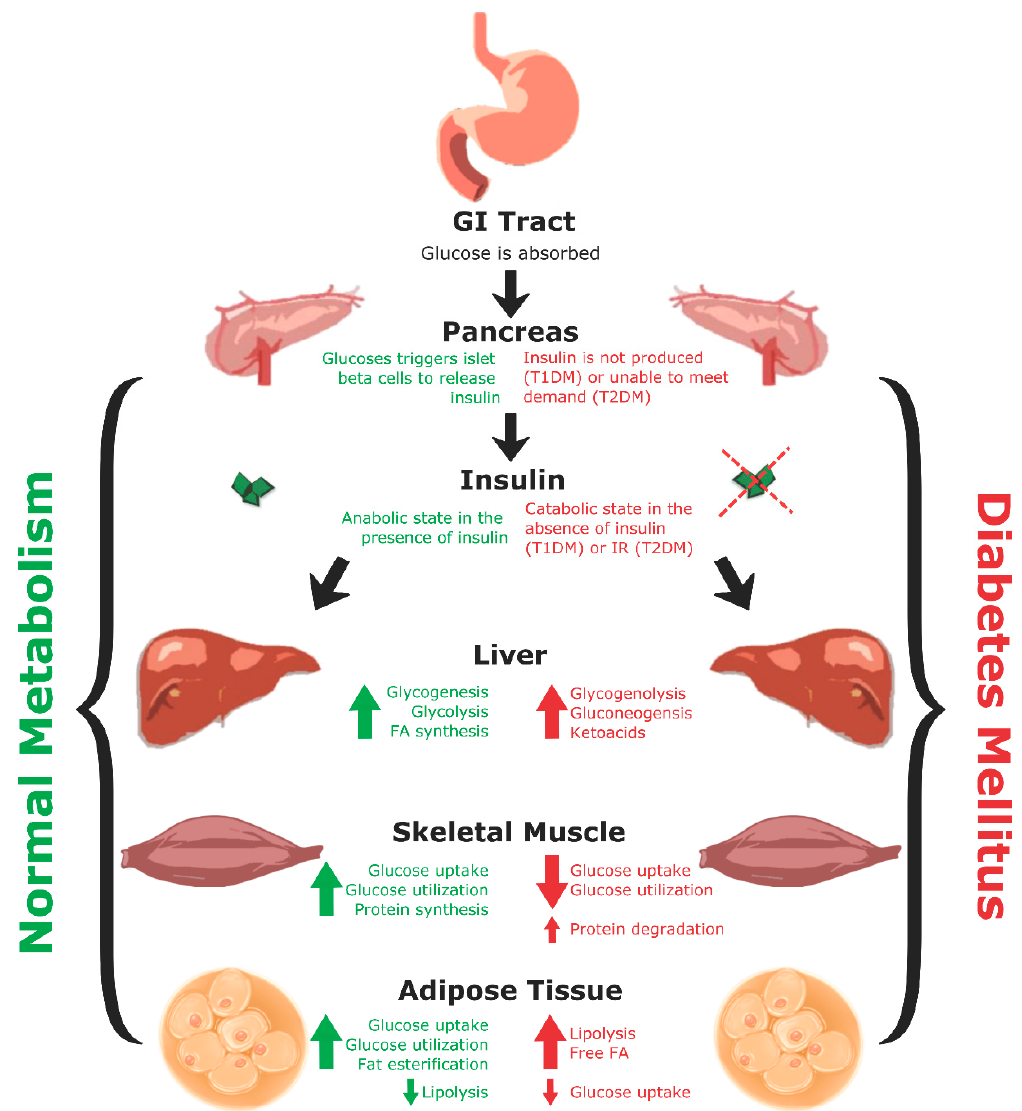
Figure 1. A comparison of normal metabolism to metabolism in DM. Under conditions of normal metabolism, glucose is absorbed from the GI tract and triggers pancreatic islet beta cells to release the hormone insulin. Insulin initiates a series of anabolic events in the liver, skeletal muscle, and adipose tissue. In the liver, insulin causes an increase of glucose utilization and FA synthesis. In skeletal muscle, it increases rates of protein synthesis, glucose utilization, and fuel uptake while decreasing rates of protein degradation. In adipose tissue, insulin increases rates of glucose uptake and utilization, fat esterification, and fuel uptake while decreasing lipolysis [16,28]. The opposite effects are seen under DM conditions, where lack of insulin or insulin resistance (IR) favors catabolic events. In DM, glycogenolysis and gluconeogenesis pathways are activated in the liver, ketoacid production increases in the liver (T1DM), glucose uptake is decreased in skeletal muscle and adipose tissue, protein degradation is increased in skeletal muscle, and lipolysis and free FA release are increased in adipose tissue [28].